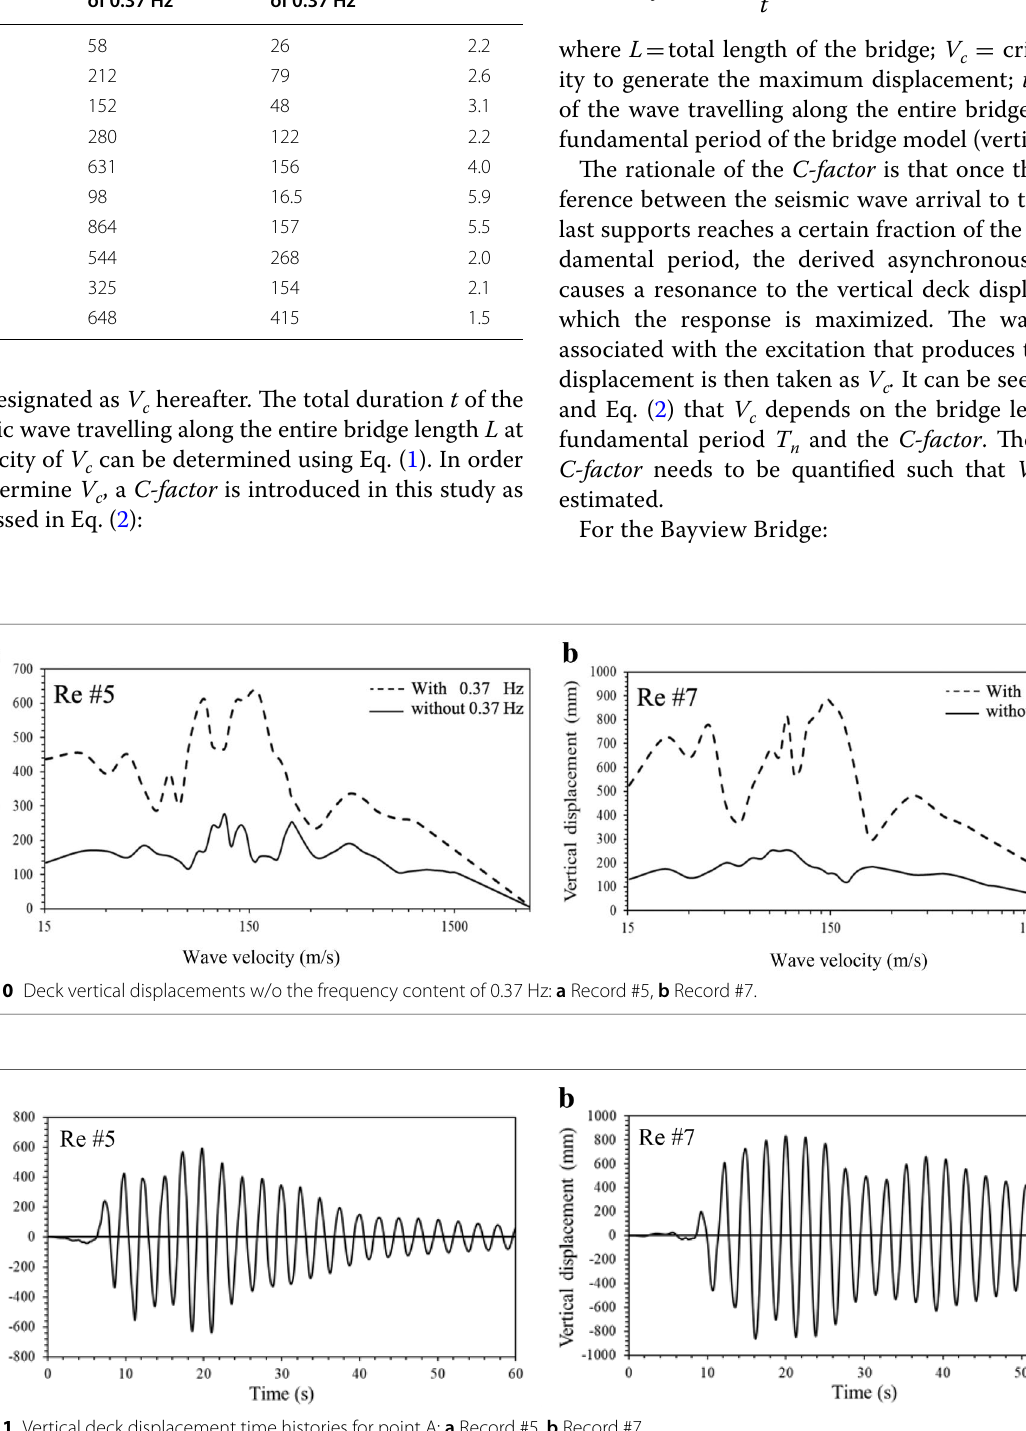
Fig. 11 Vertical deck displacement time histories for point A: a Record #5, b Record